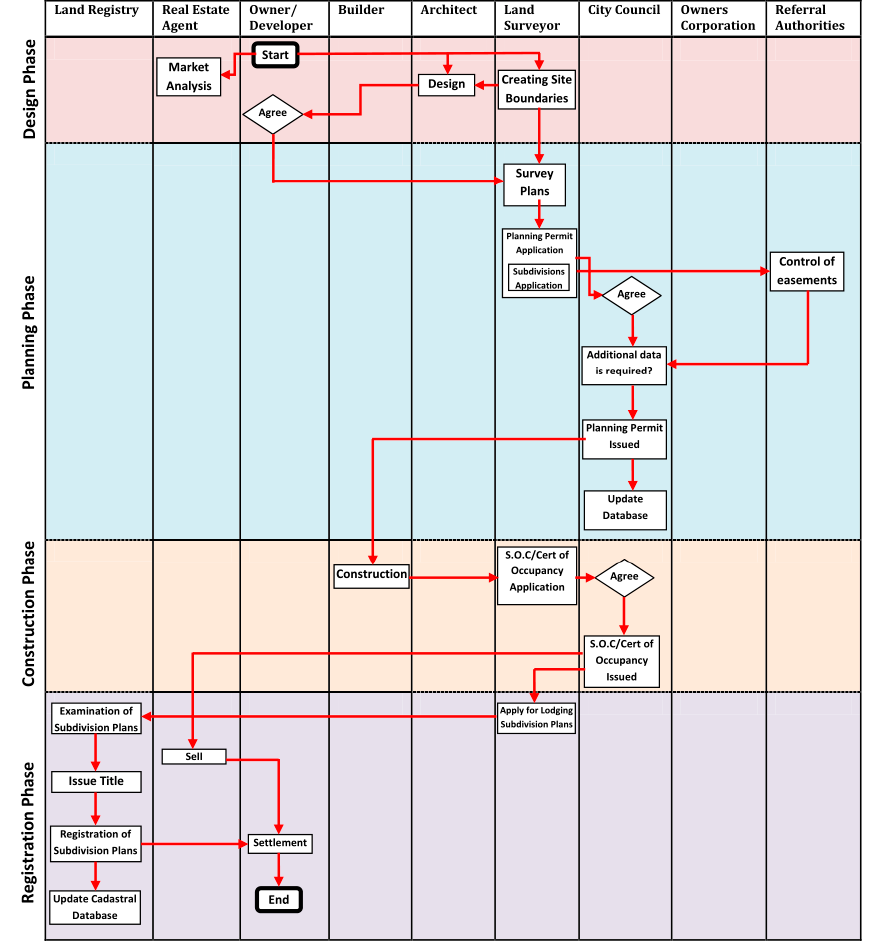
Figure 5. Current building subdivision workflow in Victoria.